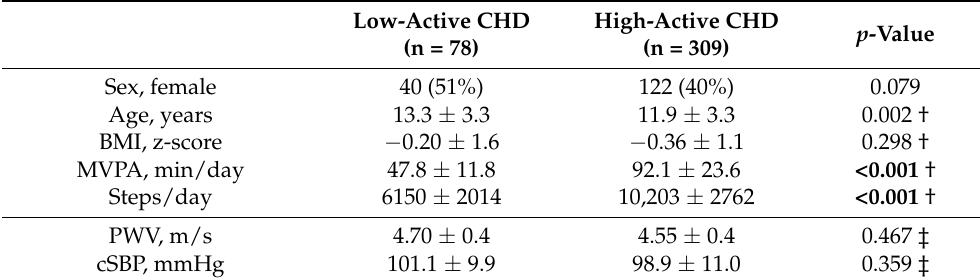
Table 3. Population characteristic of high-active and low-active children with congenital heart dis- ease.